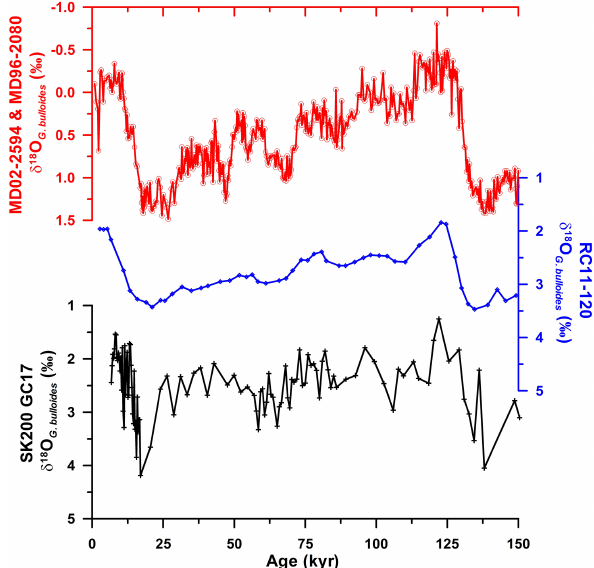
Fig. 5. A comparison of Globigerina bulloides δ 18 O in core SK 200 GC17 with that in RC11-120, which was collected from southeastern Indian Ocean (43 ◦ 31 0 S, 79 ◦ 52 0 E; 3135m water depth; Mashiotta et al., 1999) and MD02-2594 and MD96-2080 (MD02-2594: 33 ◦ 18 0 S, 17 ◦ 18 0 E; 2440m water depth; MD96- 2080: 36 ◦ 16 0 S, 19 ◦ 28 0 E; 2488m water depth; Martínez-Méndez et al., 2010). The actual G. bulloides δ 18 O values of core SK 200/17 are plotted, without taking the running average. The δ 18 O scale ( y axis) is the same for SK 200 GC17 and